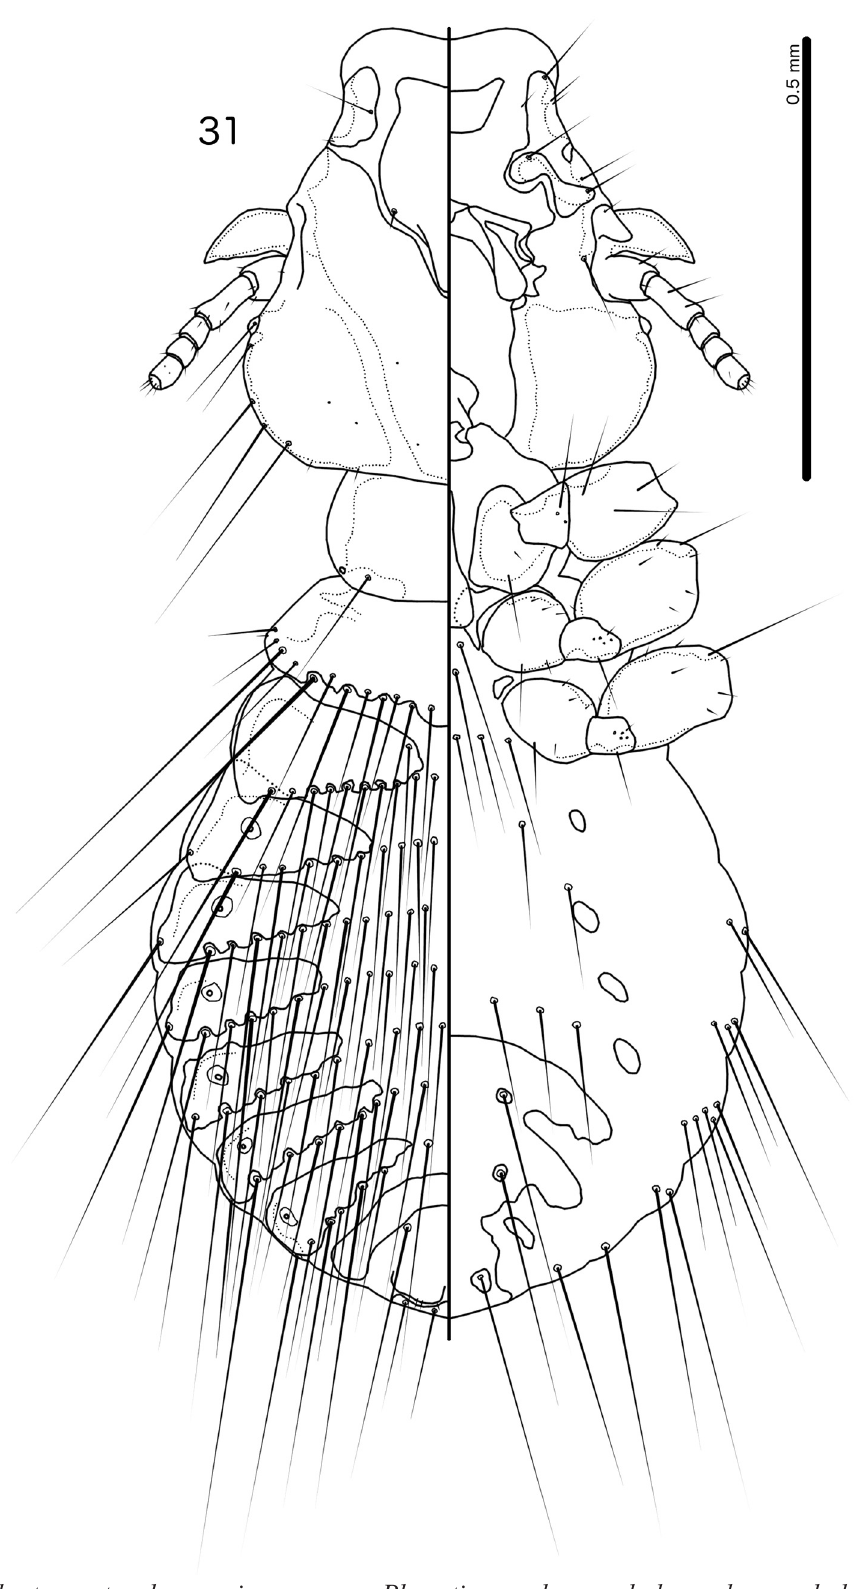
Fig. 31. Philopterus stansburyensis sp. nov. ex Pheucticus melanocephalus melanocephalus (Swainson, 1827), male habitus, dorsal and ventral